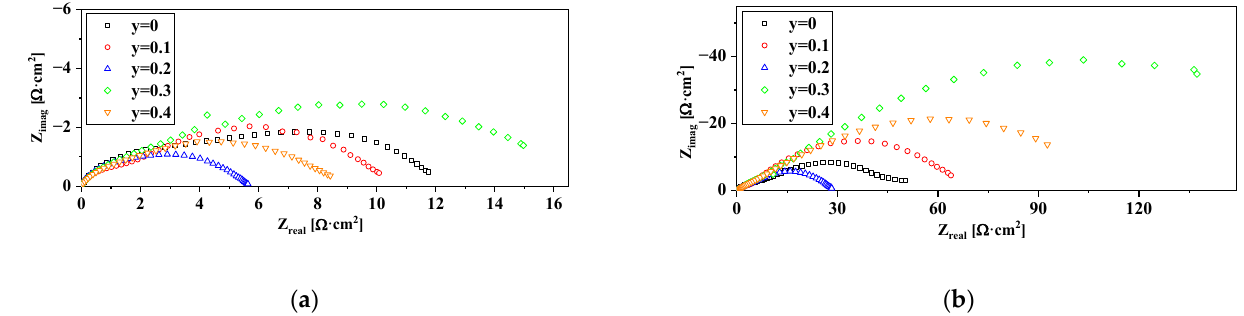
Figure 9. Nyquist plots obtained for the Nd 1.6 Ca 0.4 Ni 1−y Cu y O 4+δ /SDC symmetrical cells with functional layers sintered at 1000 °C: at 700 °C ( a ) and at 600 °C ( b ), humidified air. Ohmic electrolyte resistance was subtracted from the spectra forthe sake of easier comparison of the electrode performances.